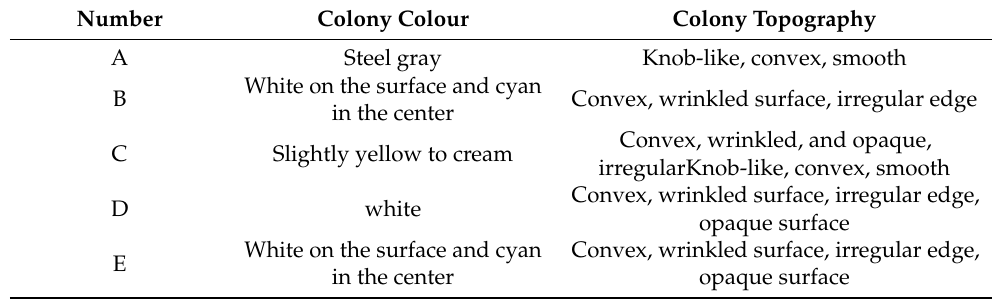
Table 1. Colony morphotypes of indigenous wine yeasts of KFP on WL nutrient agar.